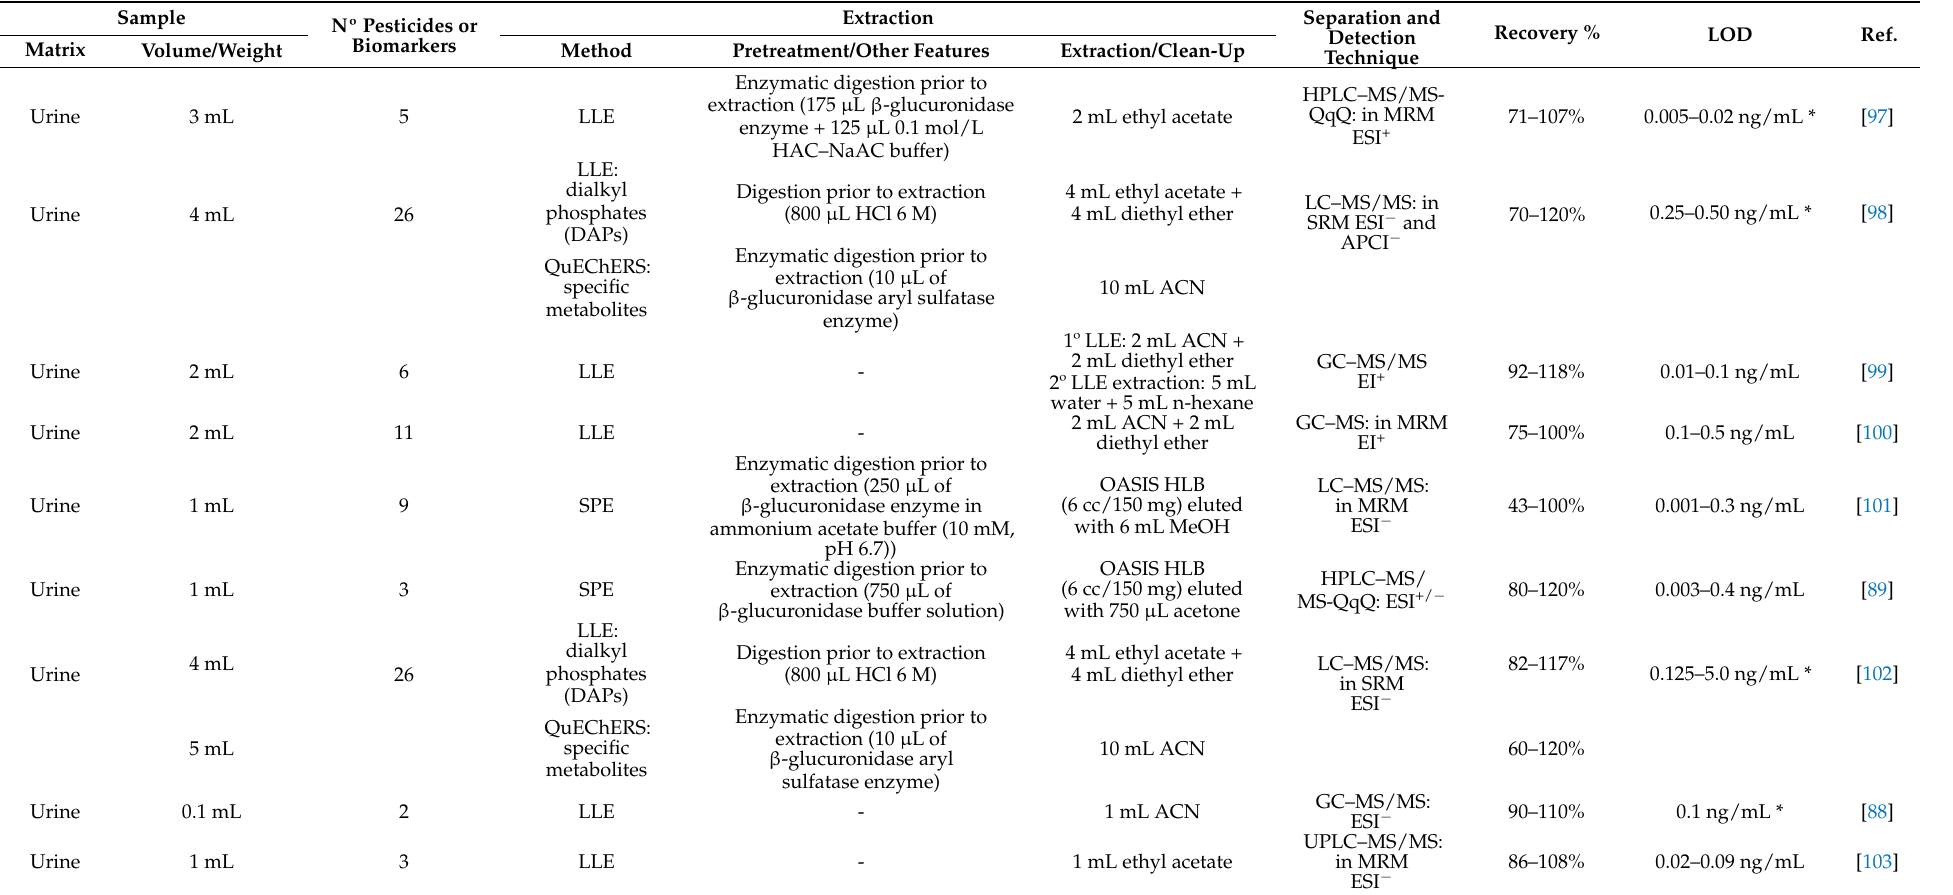
Table 2. Analytical methods published between 2019 and 2021 for the analysis of pesticides in biological matrices and between 2018 and 2021 for the wastewater-based epidemiology (WBE) studies to analyze human exposure to pesticide